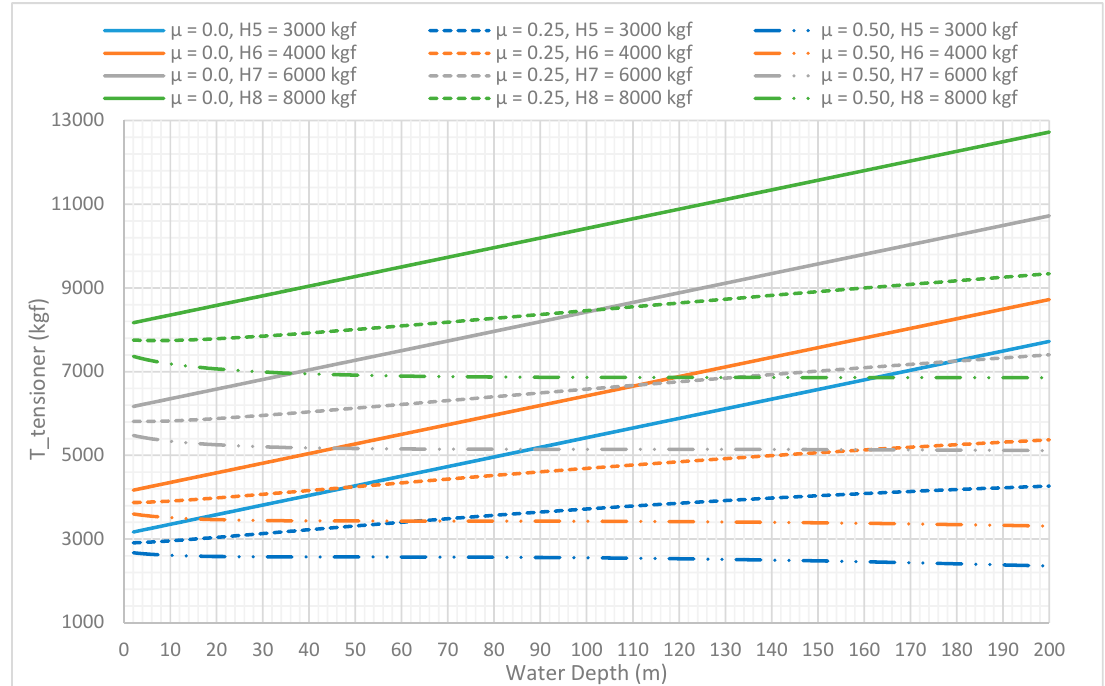
Figure 20. Cable tension variation at ship using different friction coefficients (0–0.50), water depths (2 m–200 m) and bottom tensions (3000 kgf–8000 kgf).